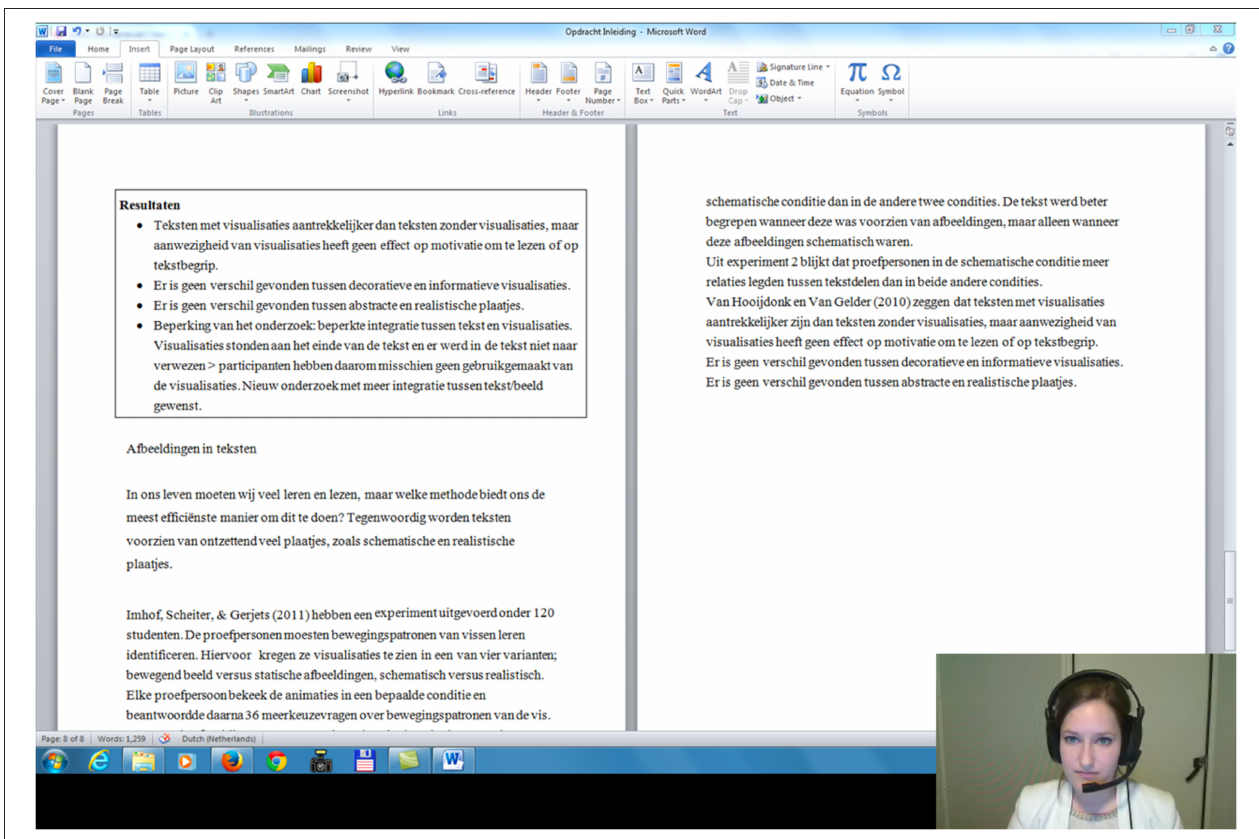
FIGURE 1 | Screenshot of a video clip with the novice model. The individual depicted in this image has granted written permission for this image to be used in all languages and for all editions and formats, including